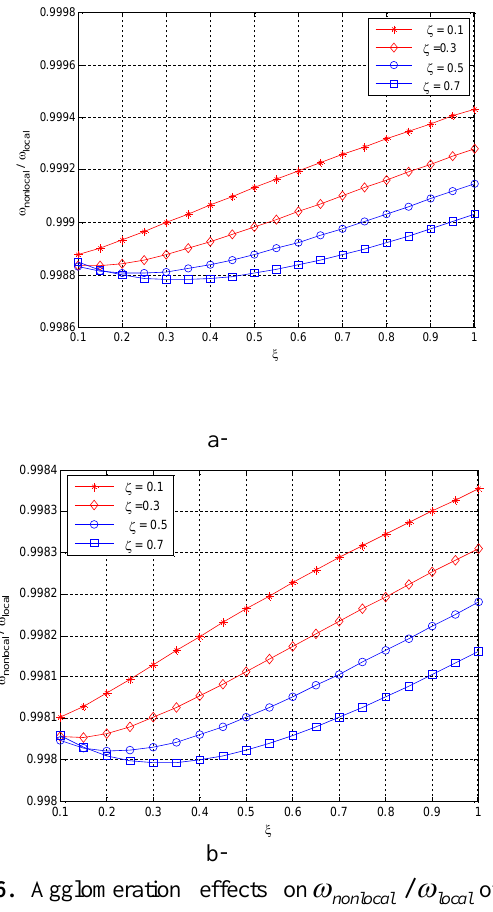
  of nonlocal local